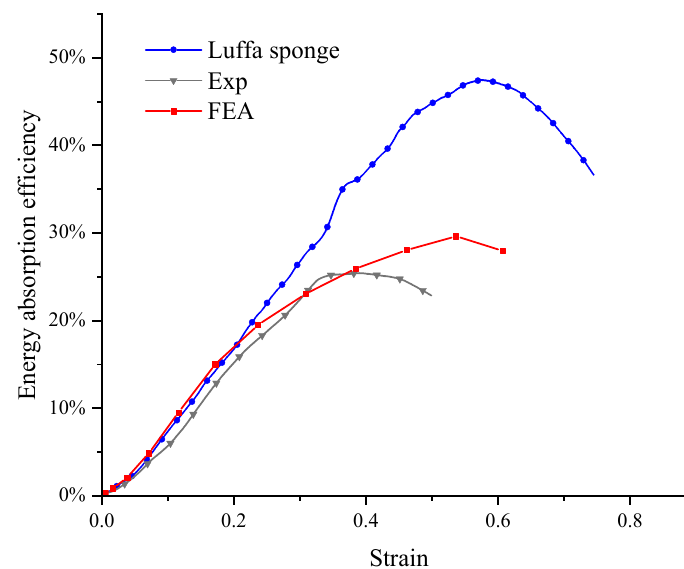
Figure 12. The comparison of energy absorption efficiency ( η ) between FEA, experiment and lu ff a sponge.